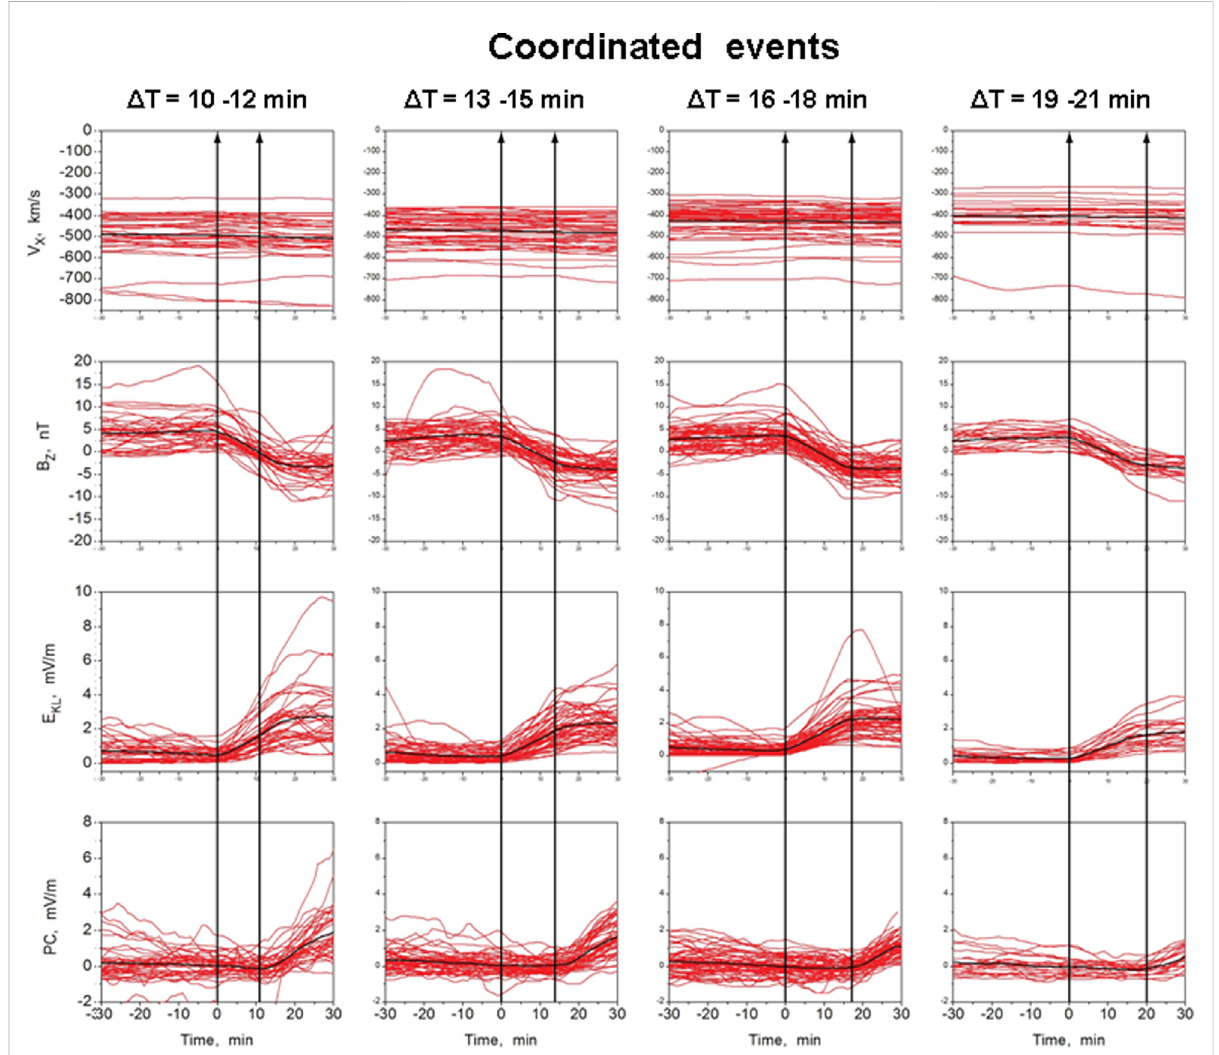
FIGURE 8 Timeevolutionofthe15-minsmoothedvalues V X , B Z , E KL and PC observedincaseofcoordinatedsubstormeventswithdelaytimes Δ T=10 – 12, 13 – 15, 16 – 18, and 19 – 21 min (Troshichev and Sormakov,